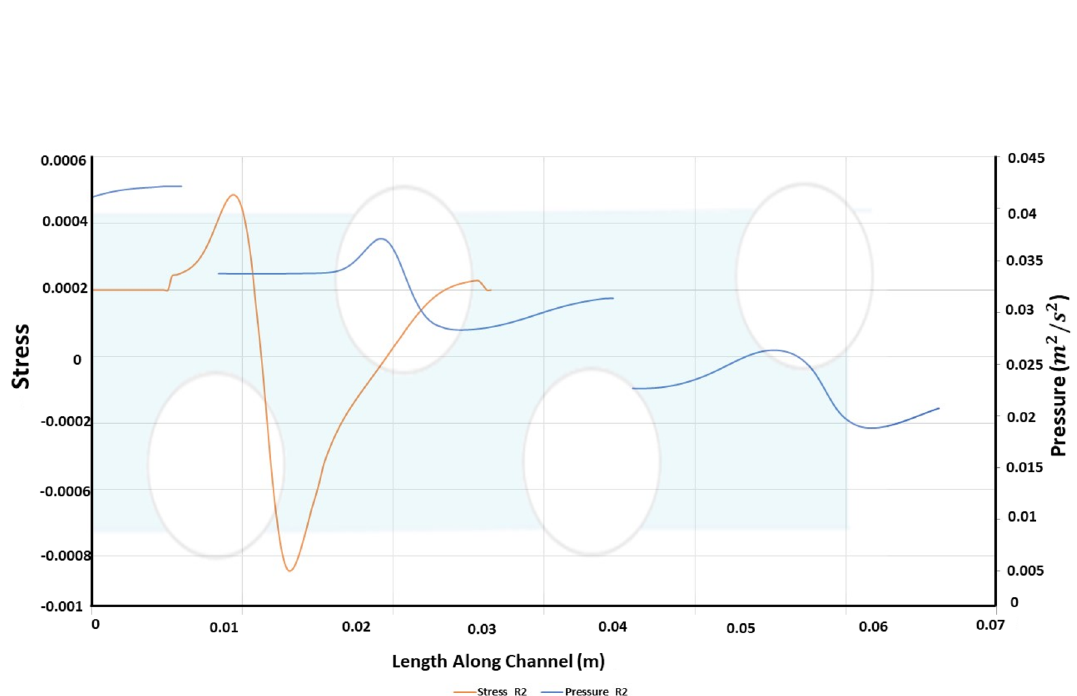
Figure 11. Length along channel vs stress and pressure for